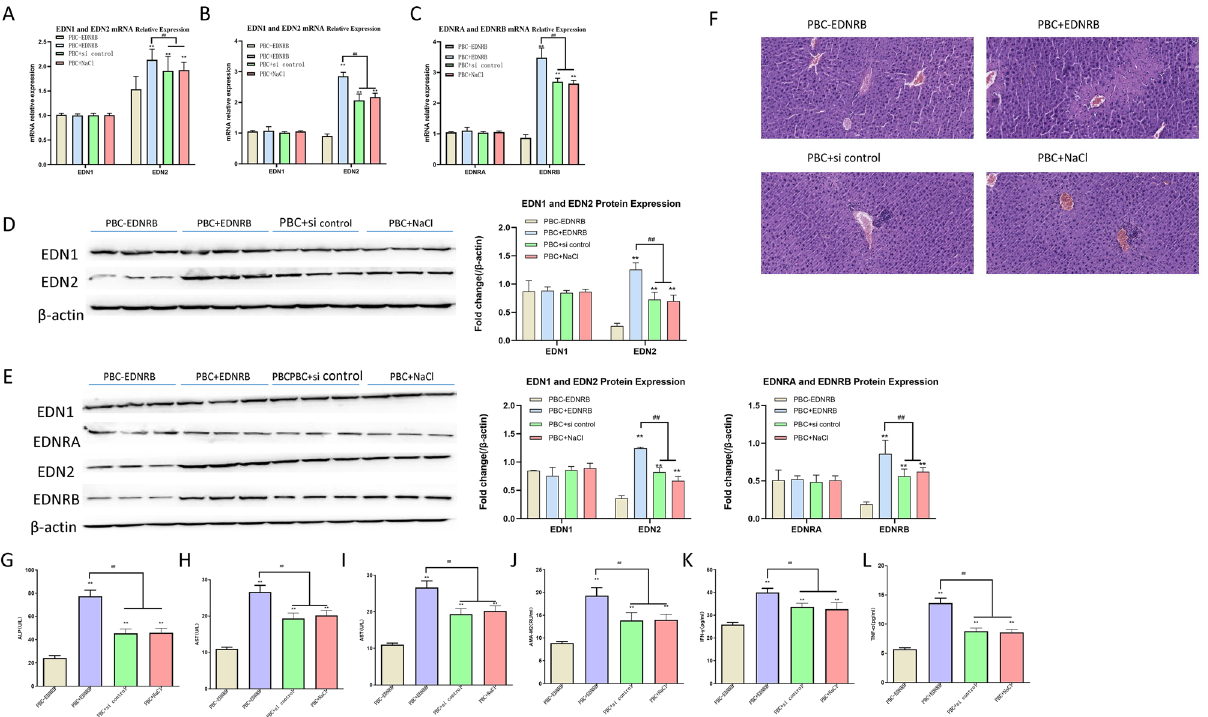
Figure 5. Effects of EDNRB overexpression or knockdown on PBC development. ( A ) Determination of EDN1 and EDN2 mRNAs was accomplished with RT-qPCR technique in sera of PBC mice injected with normal saline (PBC + NaCl), control adenoviruses (PBC + Si Control), Ad-shEDNRB adenoviruses (PBC-EDNRB), and Ad-EDNRB adenoviruses (PBC + EDNRB). Each group contained 10 mice. ( B and C ) RT-qPCR assay was used to measure levels of EDN1, EDNRA, EDN2, and EDNRB mRNAs in liver tissues of PBC mice injected with normal saline, control adenoviruses, Ad-shEDNRB adenoviruses and Ad-EDNRB adenoviruses. Each group contained 10 mice. ( D ) Measurement of EDN1 and EDN2 expression at protein levels was examined with western blotting assay in serum samples of PBC mice injected with normal saline, control adenoviruses, Ad-shEDNRB adenoviruses, and Ad-EDNRB adenoviruses. Each group contained 3 mice. ( E ) Levels of EDN1, EDNRA, EDN2 and EDNRB proteins were determined with western blotting technique in liver tissues of PBC mice injected with normal saline, control adenoviruses, Ad-shEDNRB adenoviruses, and Ad-EDNRB adenoviruses. Each group contained 3 mice. ( F ) HE staining of liver tissues of mice injected with normal saline, control adenoviruses, Ad-shEDNRB adenoviruses, and Ad-EDNRB adenoviruses. ( G – L ) Levels of ALP, AST, ALT, AMA-M2, IFN-γ and TNFα in serum samples of PBC mice injected with normal saline, control adenoviruses, Ad-shEDNRB adenoviruses, and Ad-EDNRB adenoviruses were measured with corresponding kits and ELISA